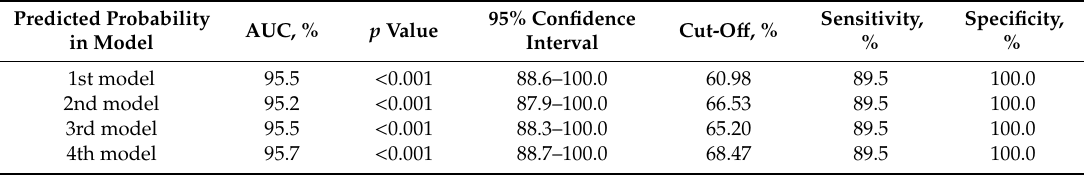
Table 3. ROC analysis of the predicted probability of logistic regression models for the likelihood that the subject has Alzheimer’s